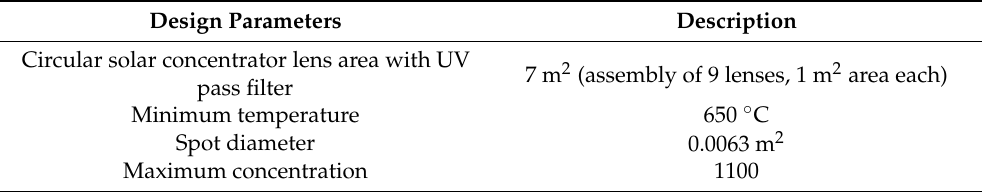
Table 4. Proposed design specifications of Fresnel lens concentrator for steam